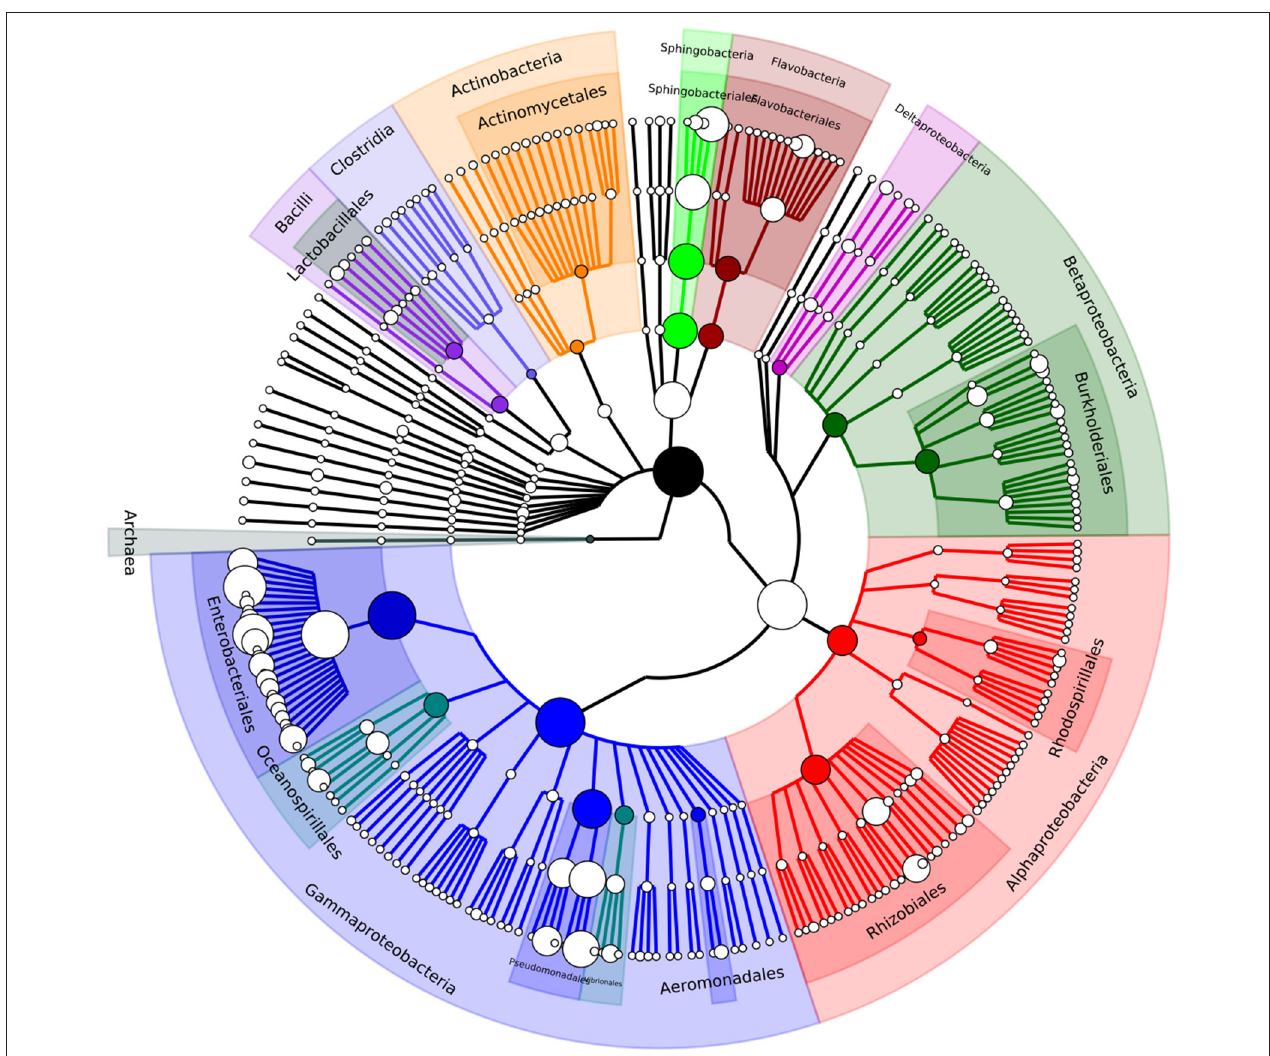
FIGURE 1 | A phylogenetic tree showing the diversity of the A. ater gut microbiome down to genus level. Visualised using GraPhlAn (Asnicar et al., 2015).